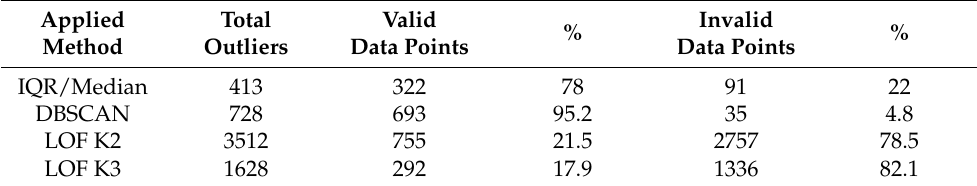
Table 1. Number of valid/invalid outliers detected using the implemented scoring method for swimming pool complex.